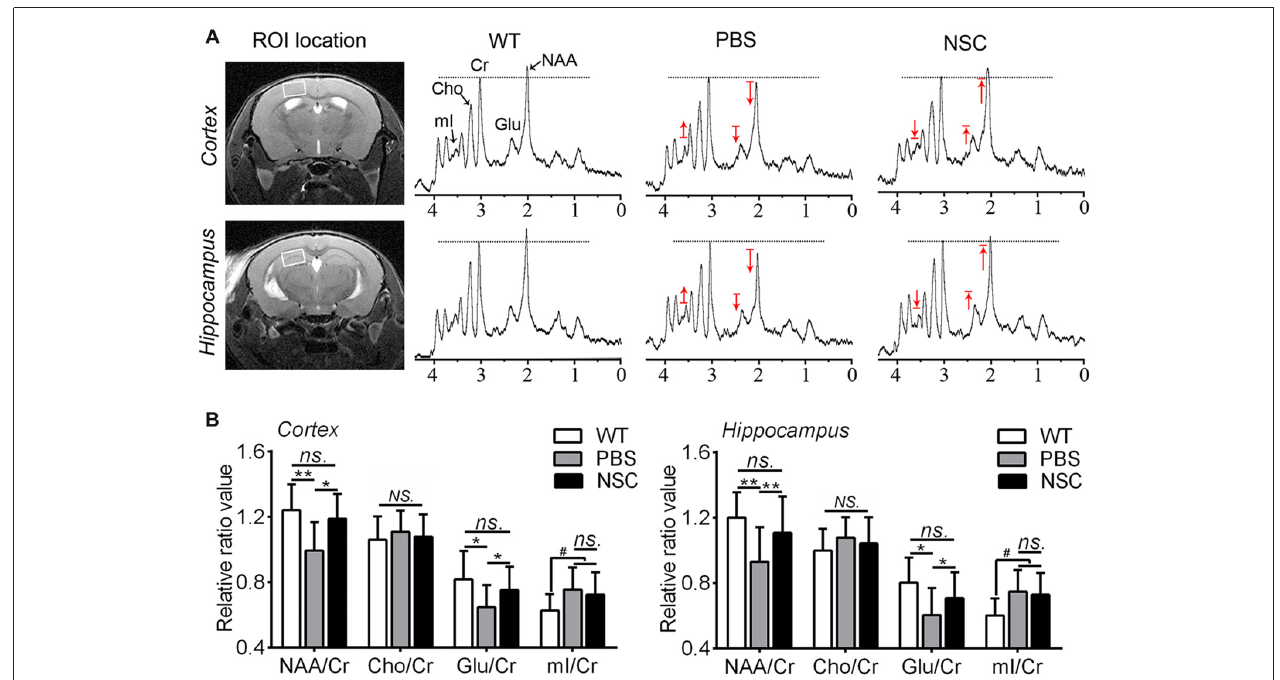
FIGURE 7 | hNSCs improved brain metabolic activity in APP/PS1 mice. (A) Regions of interest (ROI) location in the brain (white box) and representative spectra from NSC, PBS group and WT mice. N-acetylaspartate (NAA) and Glu peaks are lowered while myo-inositol (mI) is elevated in the frontal cortex and hippocampus of PBS group mice compared with WT group; hNSCs increased NAA, Glu but decreased mI in AD mice compared with PBS treatment. The red arrow indicates direction of metabolic changes whereas line represents the control level of each metabolite. (B) Quantification of the relative ratios of each metabolite to creatine (Cr) in the cortex and hippocampus of three groups of mice. There was no significant difference in NAA/Cr and Glu/Cr between the NSC group and WT mice and no difference in mI/Cr between the NSC and PBS group ( ns. = p > 0.05), # p < 0.05 vs. WT mice; ∗ p < 0.05, ∗∗ p < 0.01 vs. the PBS group. No significant difference in Cho/Cr was found among three groups of mice ( NS. = p >